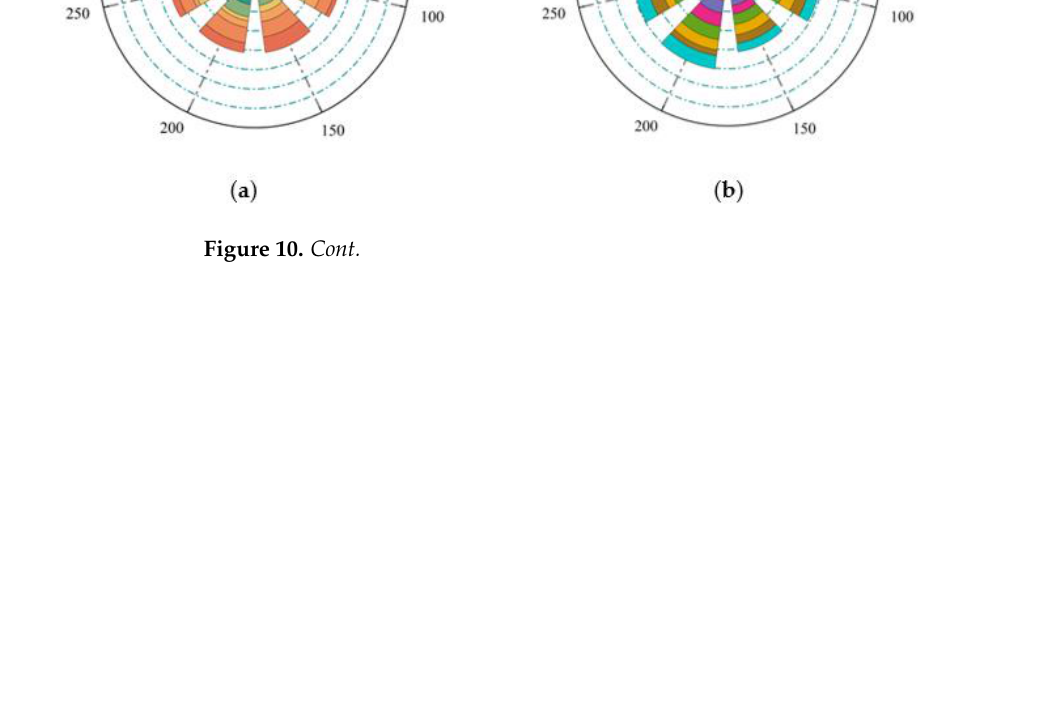
Figure 10. Comparison of evaluation indexes for MC prediction algorithms: ( a ) PSO-XGBoost; ( b ) ACO-XGBoost; ( c ) SOA-XGBoost; ( d )